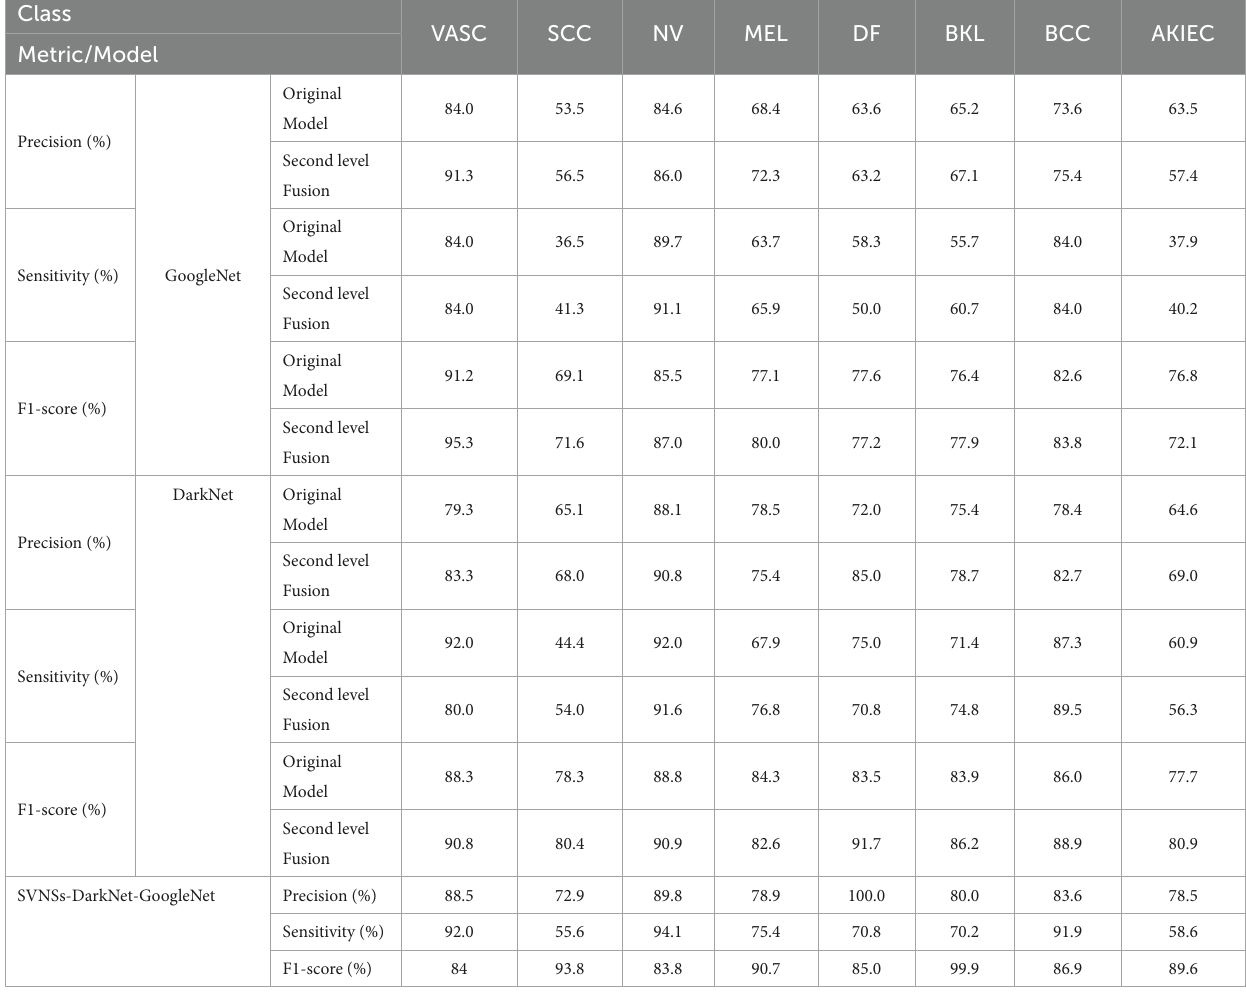
TABLE 6 Overall results of combined fused and neutrosophic experiments for eight classes.